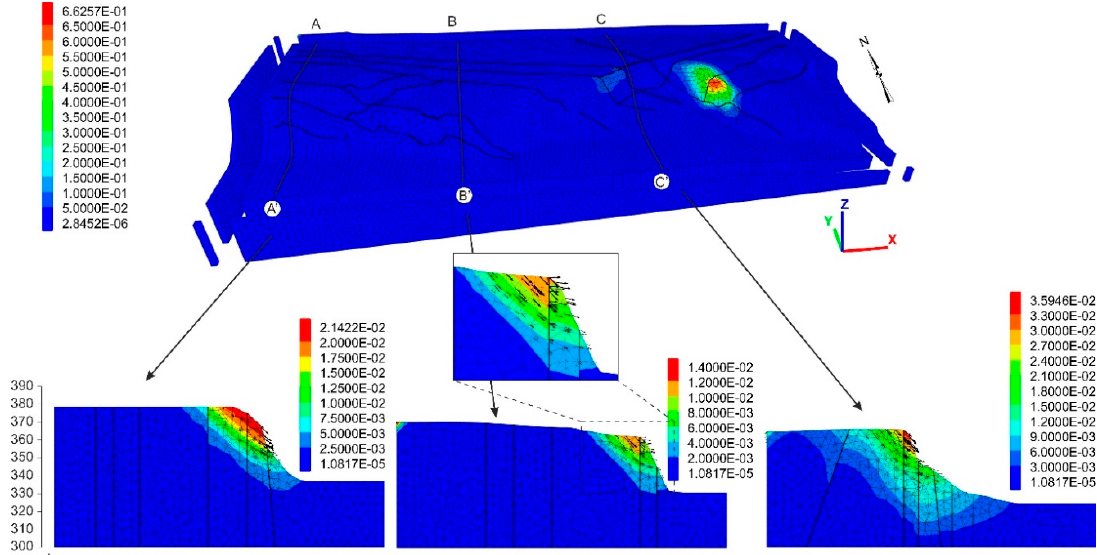
Figure 24. Contour displacements and displacement vectors (sections) of the dynamic analysis with Mw 5.5 input on the post-landslide model with discontinuities.